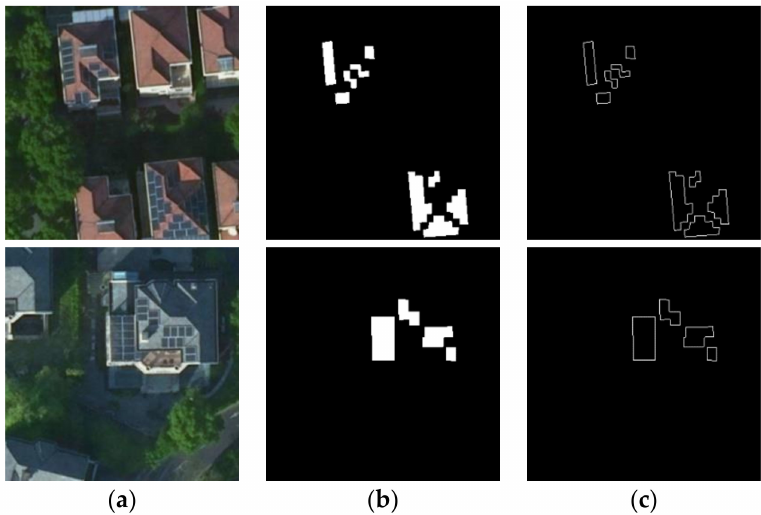
Figure 8. Samples from the Shanghai Distributed Photovoltaic Power Station data set: ( a ) Image; ( b ) segmentation label; ( c ) edge